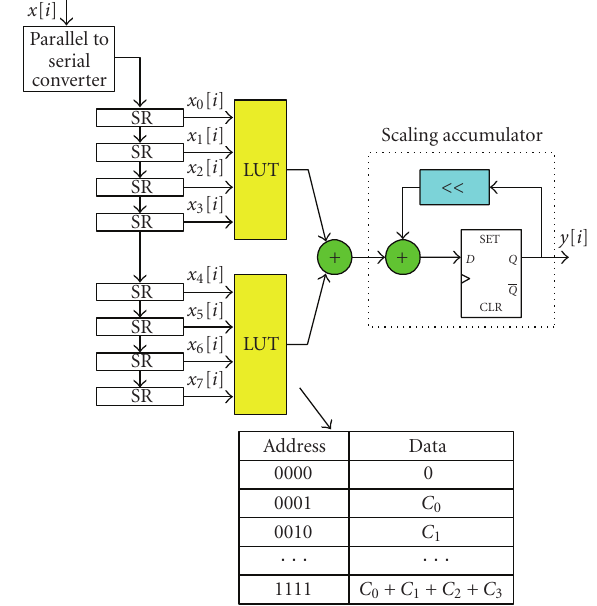
Figure 3: A serial DA FIR filter block